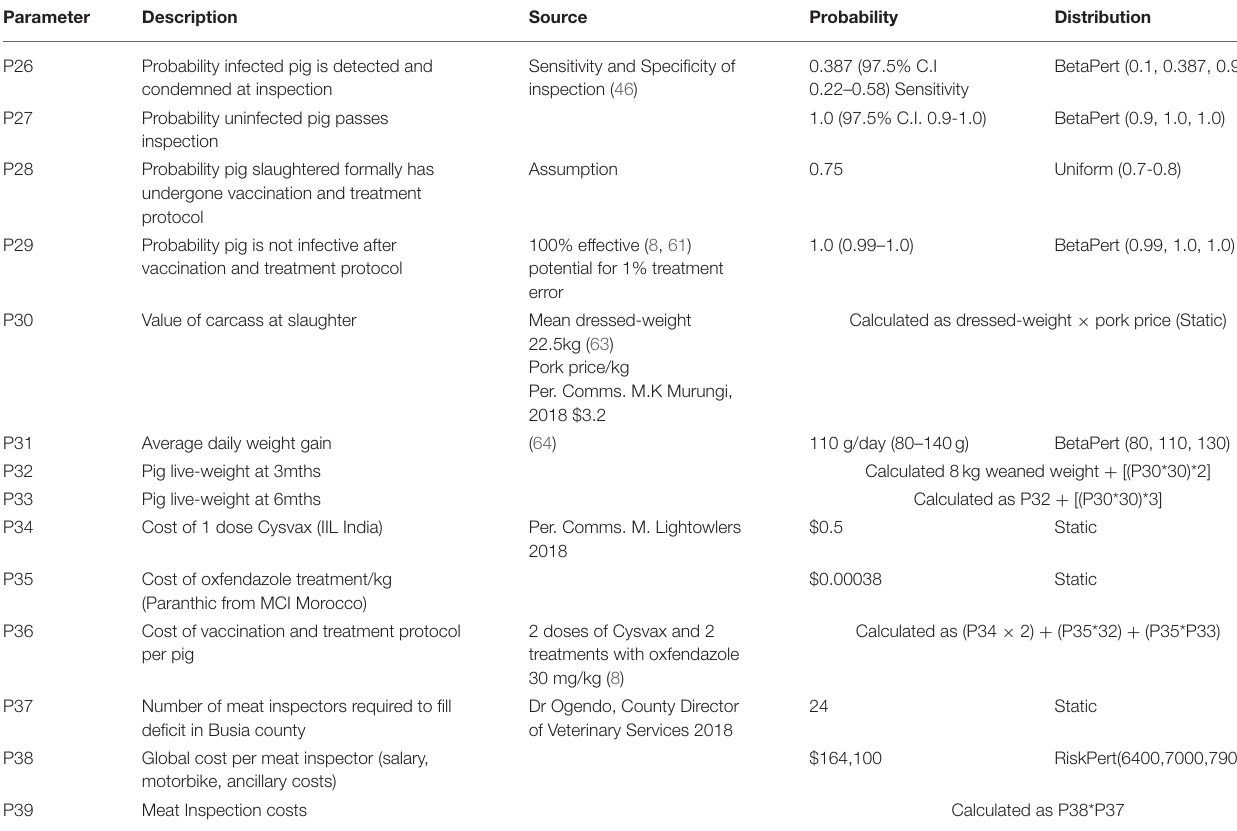
TABLE 1 | New model parameters. Parameters P1–P25 as per original model (49).